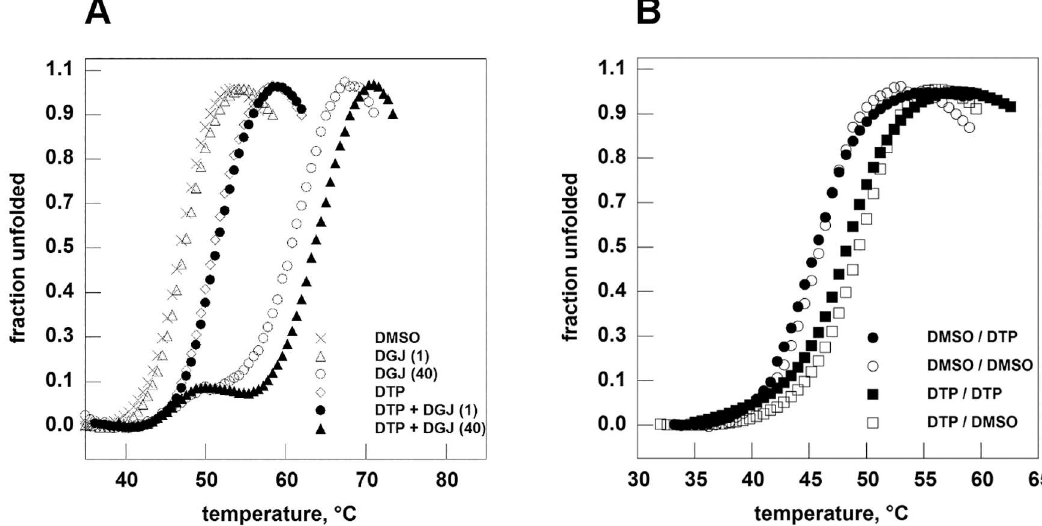
Fig 3. 2–6 dithiopurine stabilizes human lysosomal alpha-galactosidase in thermal shift assay. Panel A. Fabrazyme ® (in Na-Hepes20 mM, NaCl 150 mM, pH 7.4) was equilibratedin the presence of ligands dissolved in DMSO 20%: DGJ 1 microM (empty triangle) or 40 microM (empty circle); DTP 6 mM (empty diamond); DTP 6 mM plus DGJ 1 microM (filled circle); DTP 6 mM plus DGJ 40 microM (filled triangle). A control (with only DMSO) was also shown (x). Panel B. Fabrazyme ® (in Na-Hepes20 mM, NaCl 150 mM, pH 7.4) was incubatedin the presence of DTP 6 mM for 1 hour at 4˚C then DTP was eliminated by dialysis. A control experiment was conductedby incubatingthe enzyme only with DMSO. Both the aliquots of Fabrazyme ® were analysedby thermal shift assay in the presence of DTP 6 mM or in the presence of DMSO. Filled squares: DTP/DTP; open squares: DMSO/DTP; filled circles: DTP/DMSO; open